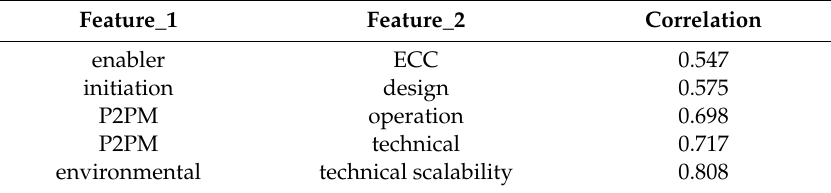
Table 9. Top 5 pairwise correlates of